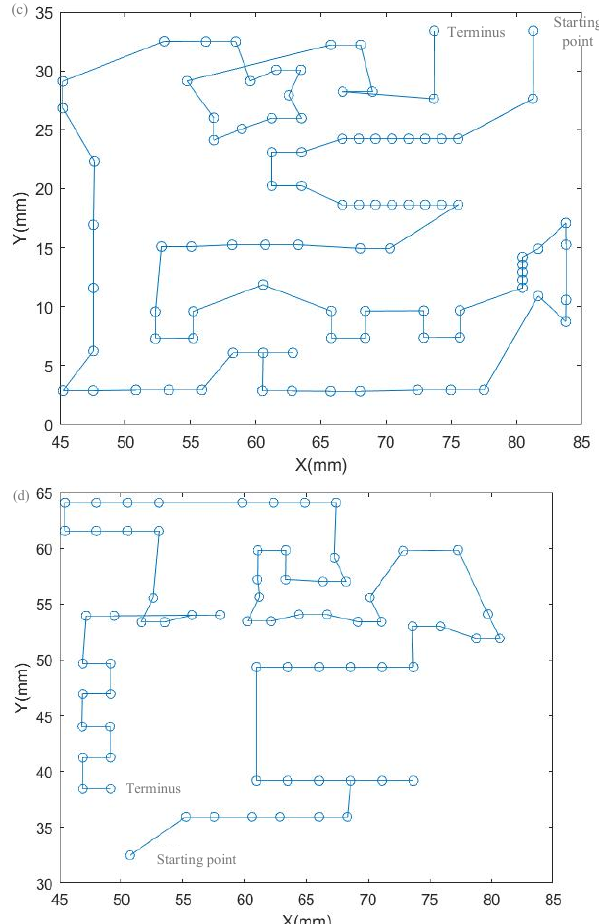
Figure 23. Optimization of the solder joint path in the processing frame. ( a ) Processing frame 1, ( b ) Processing frame 2, ( c ) Processing frame 3, ( d ) Processing frame 4.